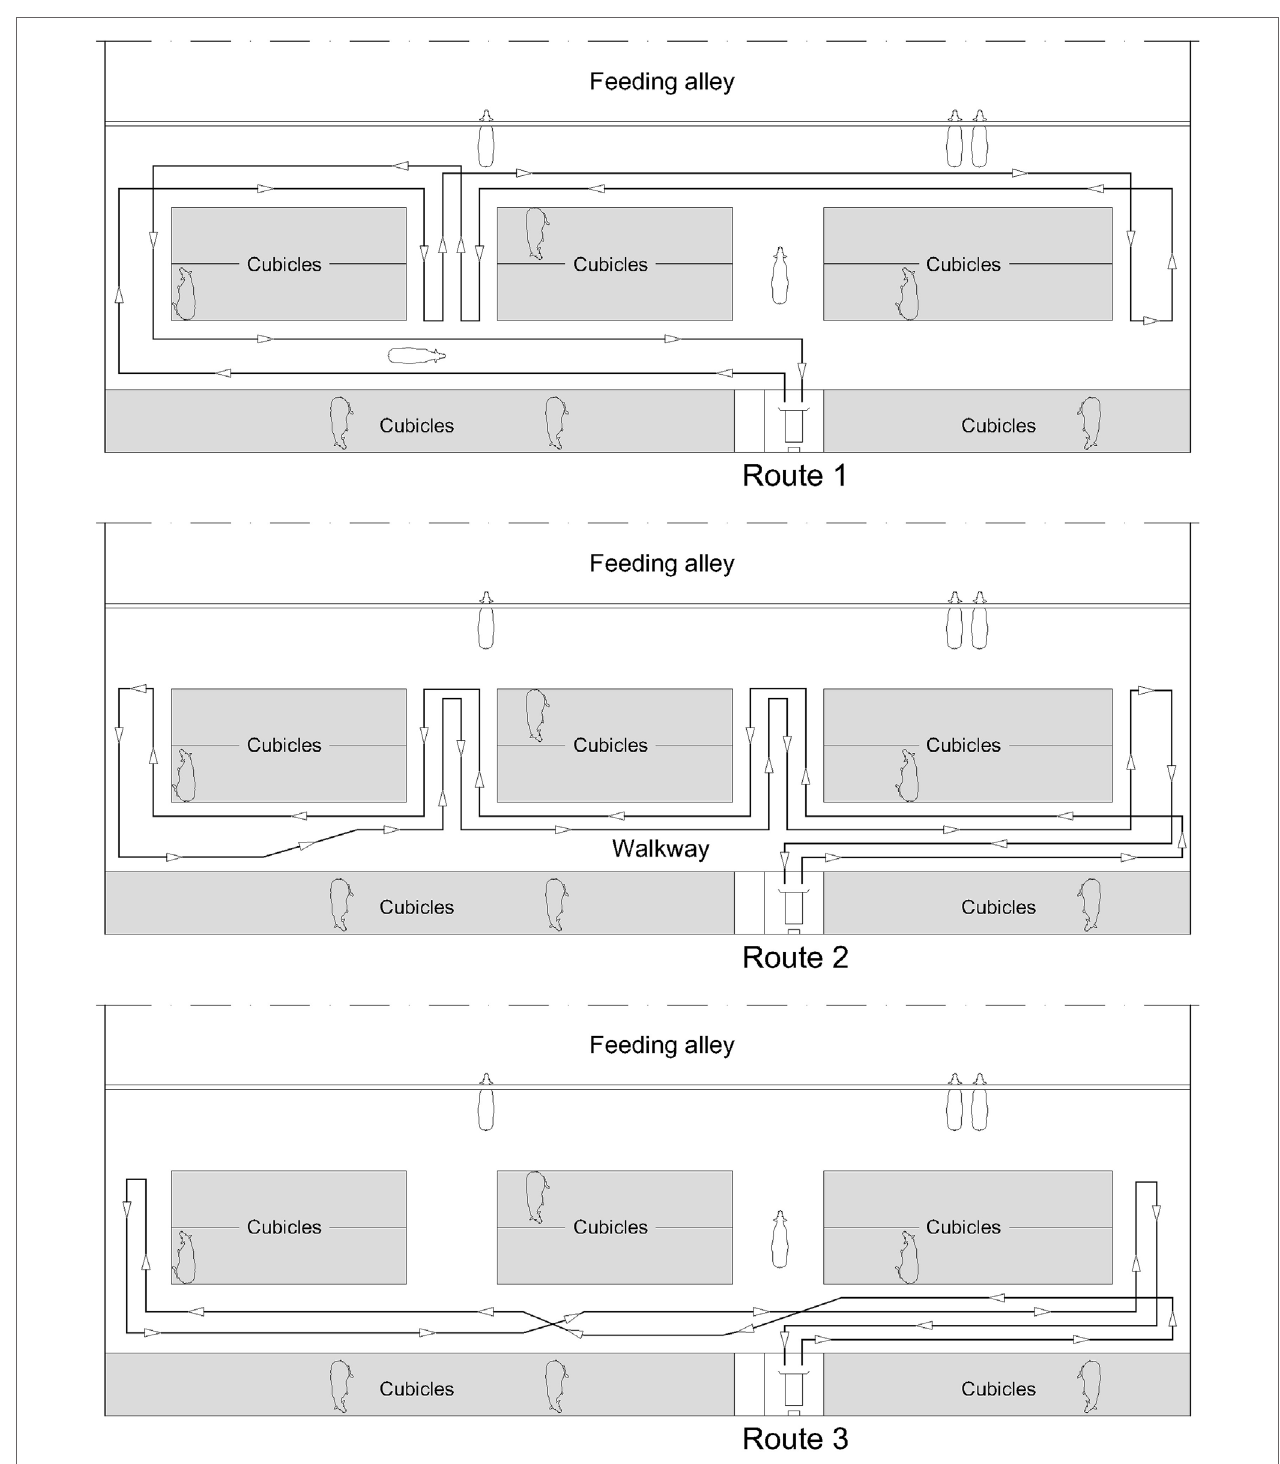
FigUre 1 | scheme of the three routes of the scraper robot in farm 3, rotating throughout each day